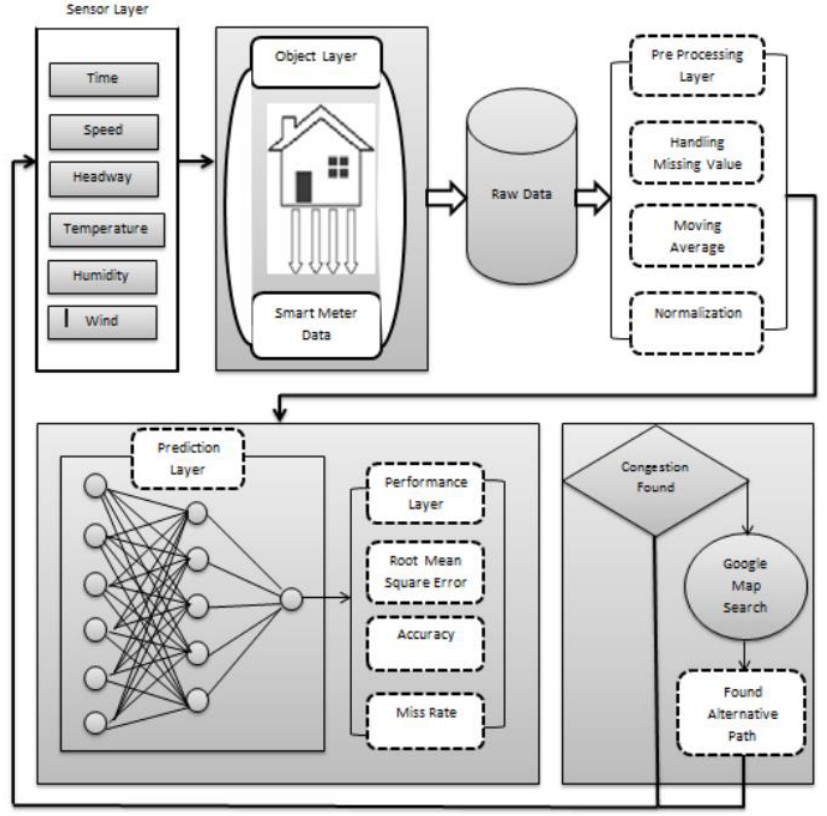
Figure 1. MSR2C-ABPNN system model [7].